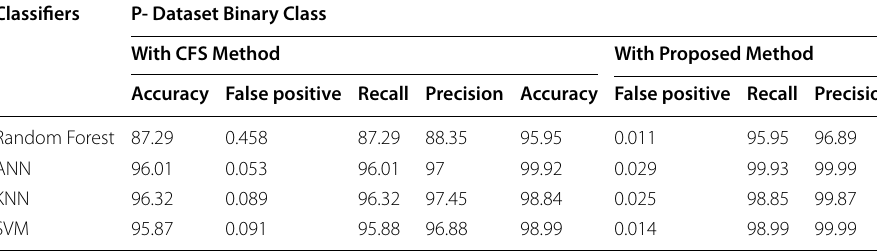
Table 22 Results of CFS method and proposed method on proposed dataset